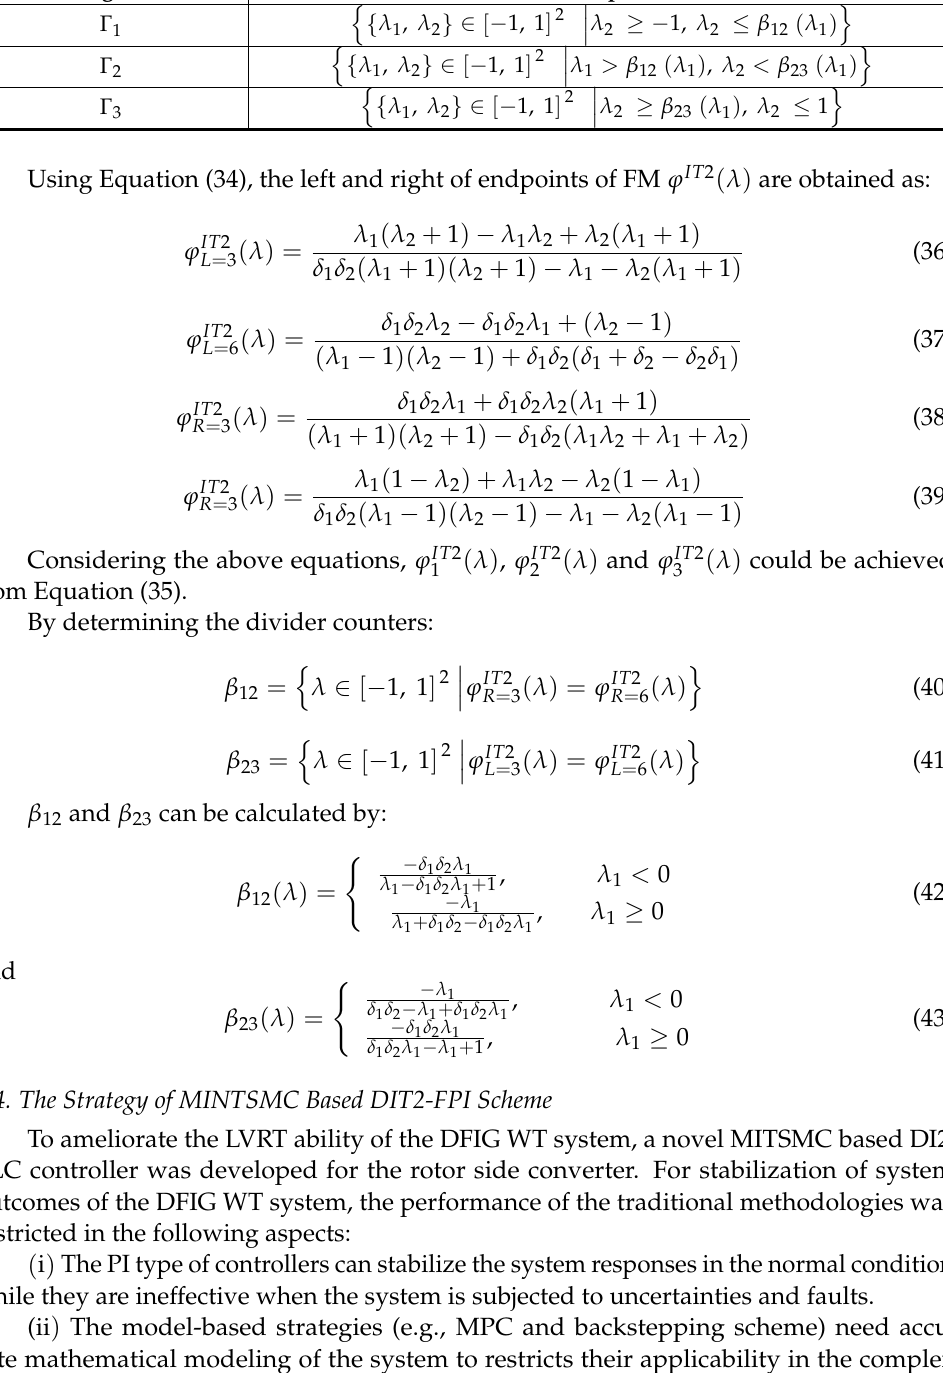
Table 2. FLC. Region